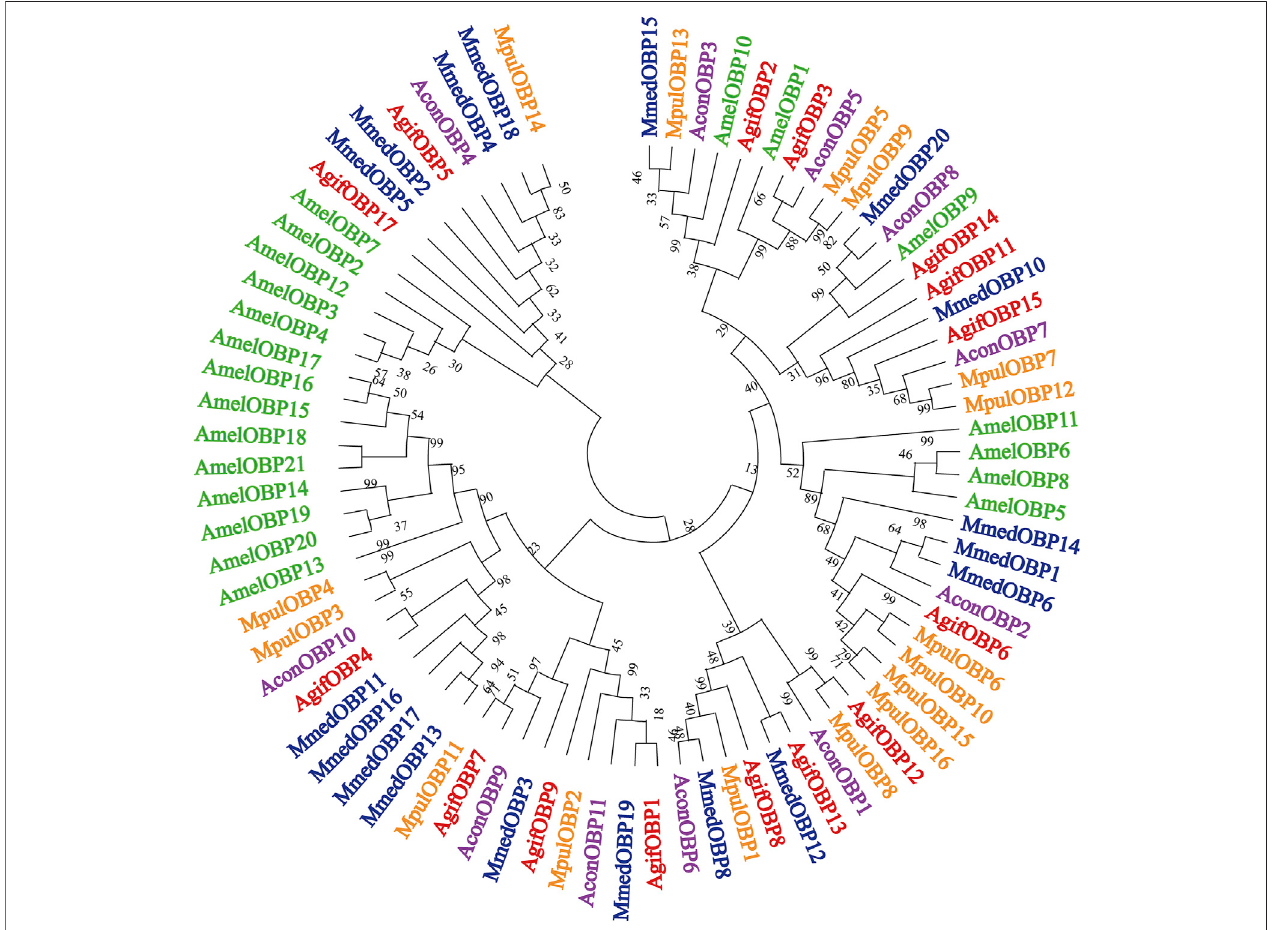
FIGURE 2 | Phylogenetic relationships of target parasitoid putative OBPs and 66 putative other hymenopteran OBPs; detailed relationships of the putative AgifOBPs (inred), MmedOBPs (inblue), AmelOBPs (ingreen), MpulOBPs (inorange),and AconOBPs (inpurple).ThetreeswereconstructedwithMEGA11usinganLG +modelandbootstrapsupportwascalculatedwith1,000rapidbootstrapreplicateswitha95%cutoff.Thespeciesnamesareabbreviatedwithfourletters,andtheirfull names with all accession numbers of the OBP amino acid sequences are provided in Supplementary Material S1 .